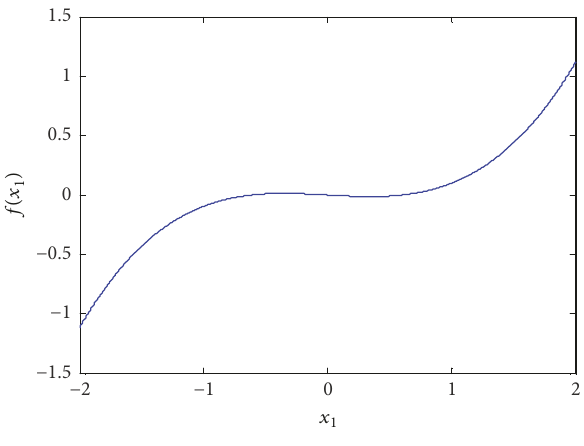
Figure 2: Approximate